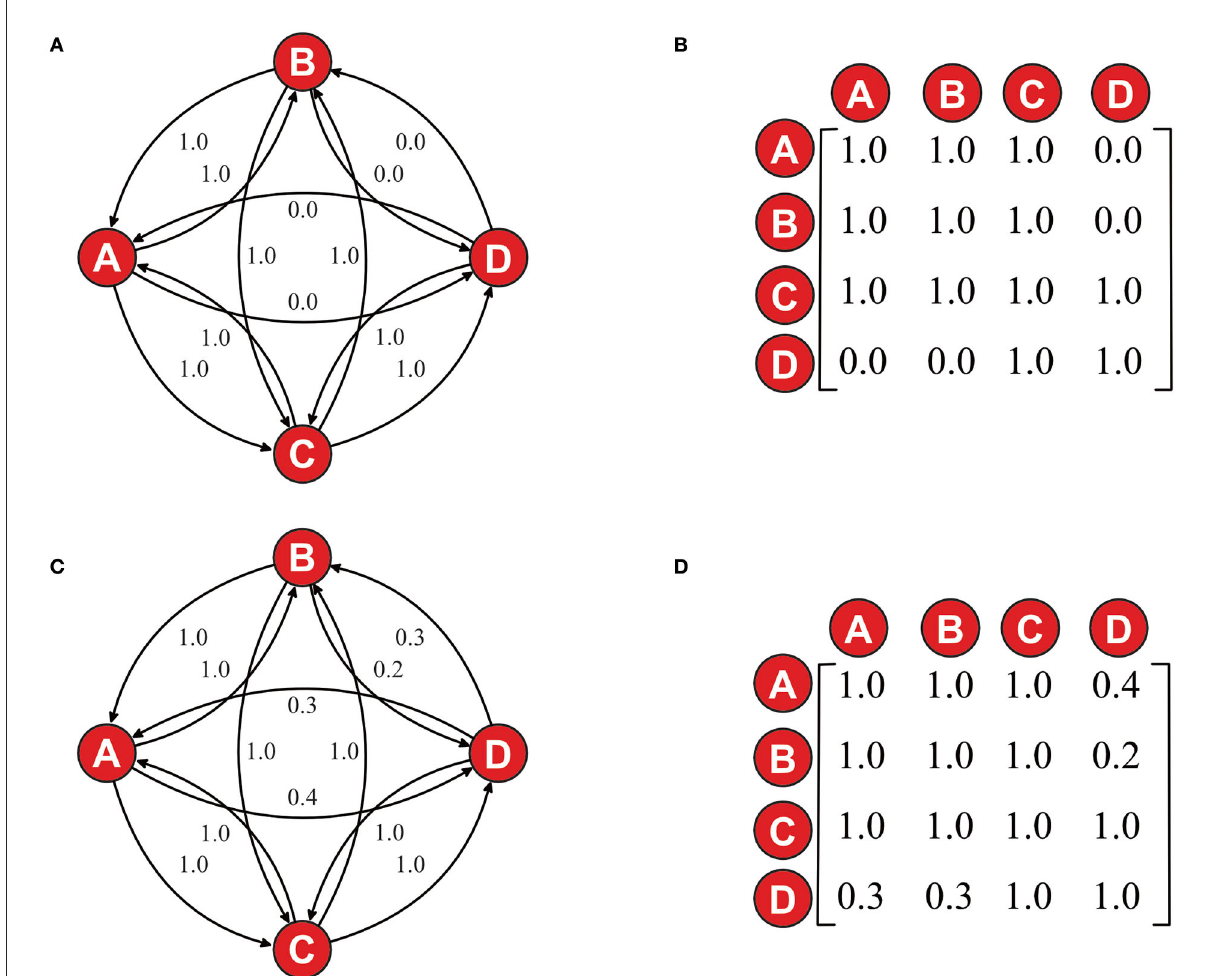
FIGURE1 (A) Graphic representation of trust network. (B) Adjacency matrix of the same network as in (A) . (C) The same graphic representation of trust network as in (A) but with updated trust relations. (D) Adjacency matrix of the same network as in (C) . The diagonal A T A, B T B, C T C, and D T D are set to 1, even though there are no reflexive